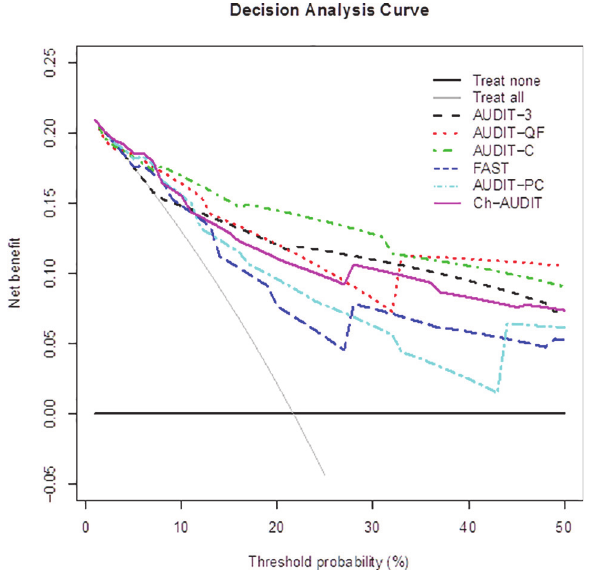
Fig 1. Decision curves showing net benefit in comparisons between various versions of